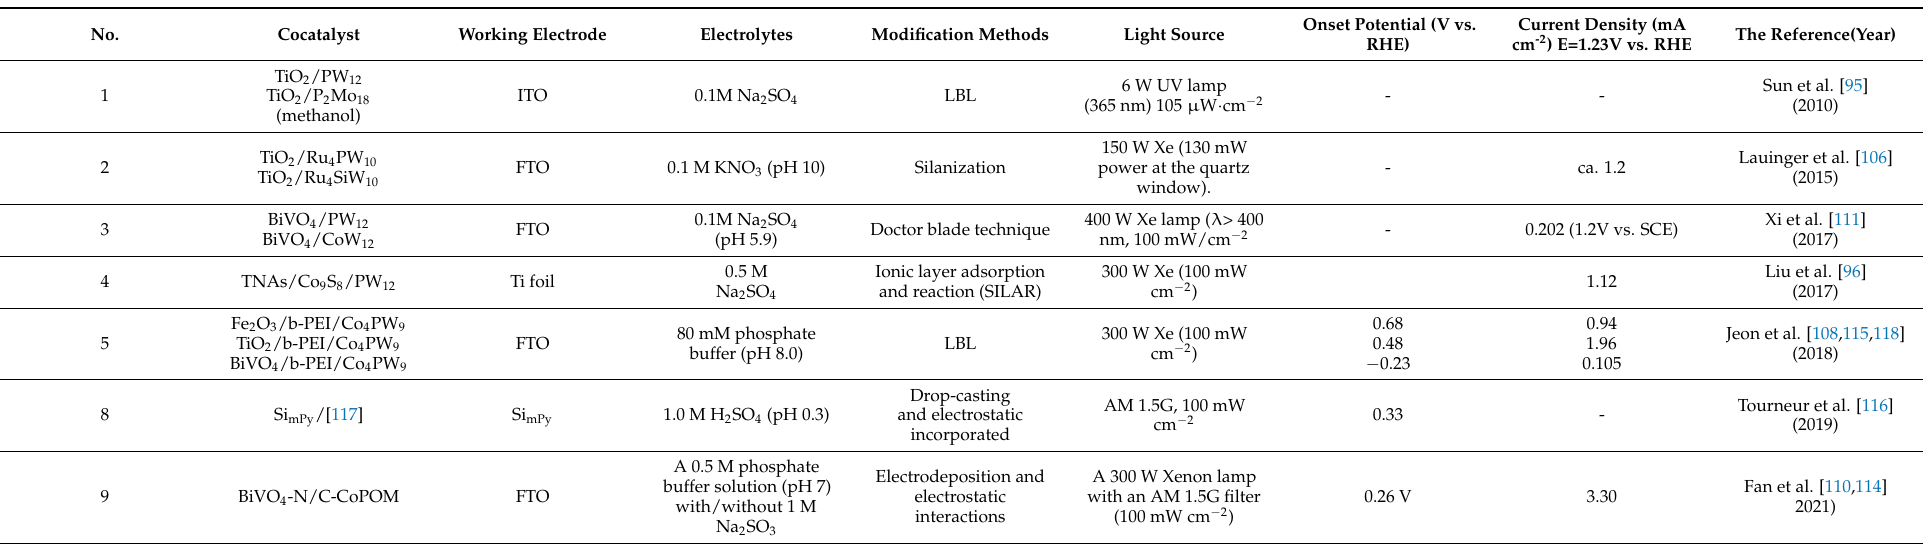
Table 2. Summary of POMs-based semiconductor compounds in